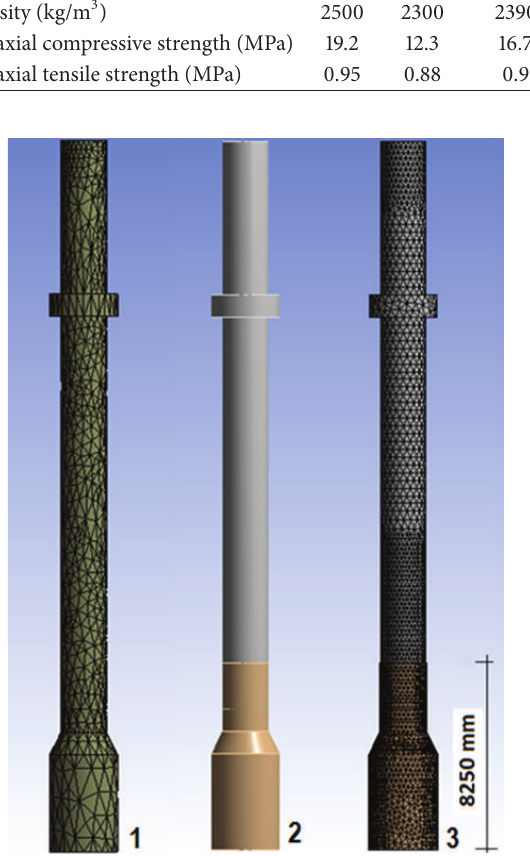
Figure 3: 3D finite element ANSYS models of the meshed bare minaret (1), FRCM strengthened minaret (2), and meshed model of FRCM strengthened minaret